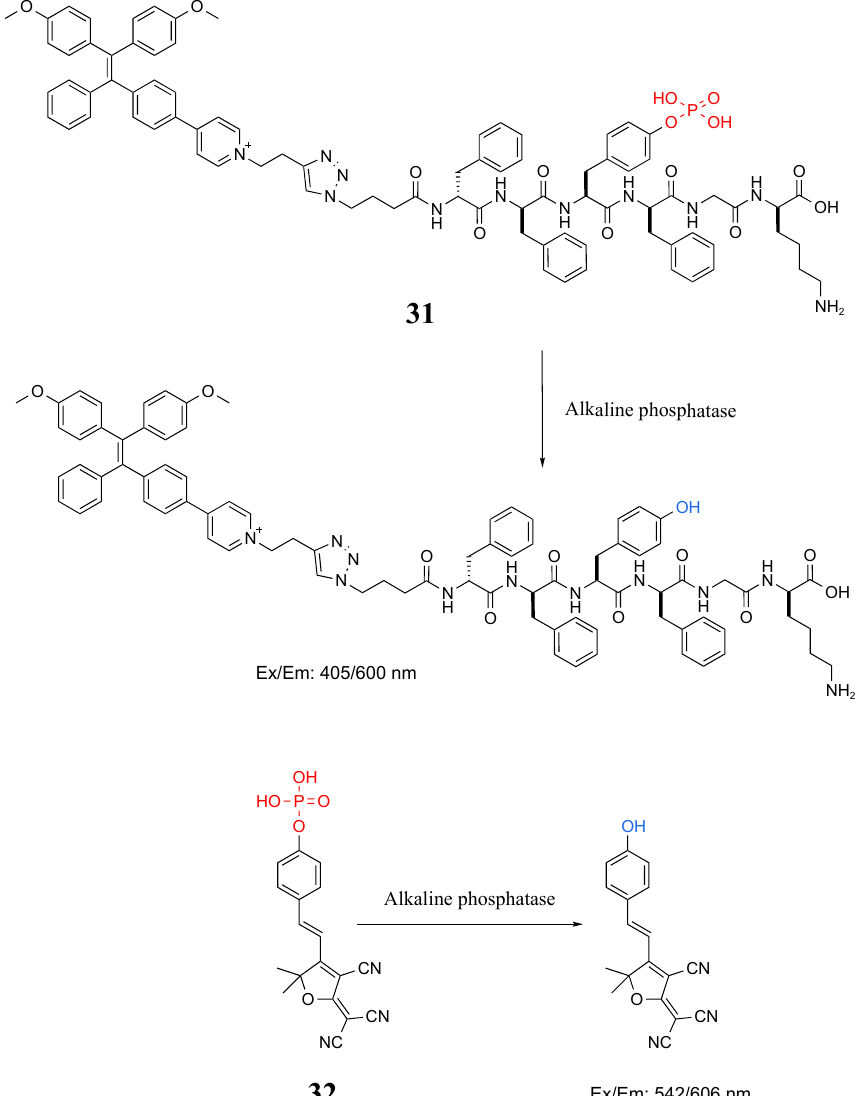
Figure 17. Structure and identification mechanisms of probes 31 – 32 .